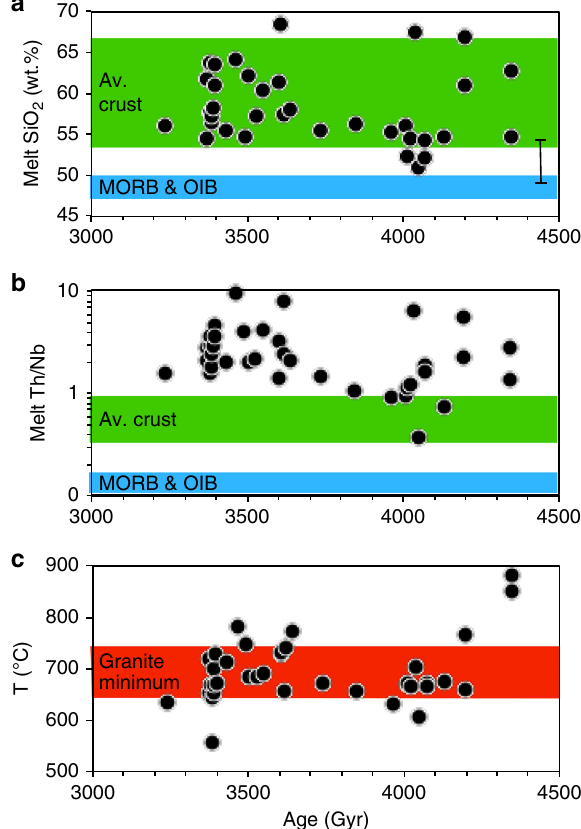
Fig. 1 Compositional evolution of Jack Hills zircon protoliths through time. a Melt SiO 2 calculated from inferred melt Th/Y is similar to average bulk crust. b Melt Th/Nb ratios are distinct from mid-ocean ridge and ocean island basalts but similar to or higher than average crust. c Zircon crystallisation temperatures are similar to the granite minimum though the parental magmas would have been hotter. Errors are smaller than the symbol size. There is no secular change in any of these parameters and all are features of typical subduction zone andesites. Average compositions of continental crustal 24 and MORB and OIB 43 are also shown. Error bar in a is 1 σ (see Methods